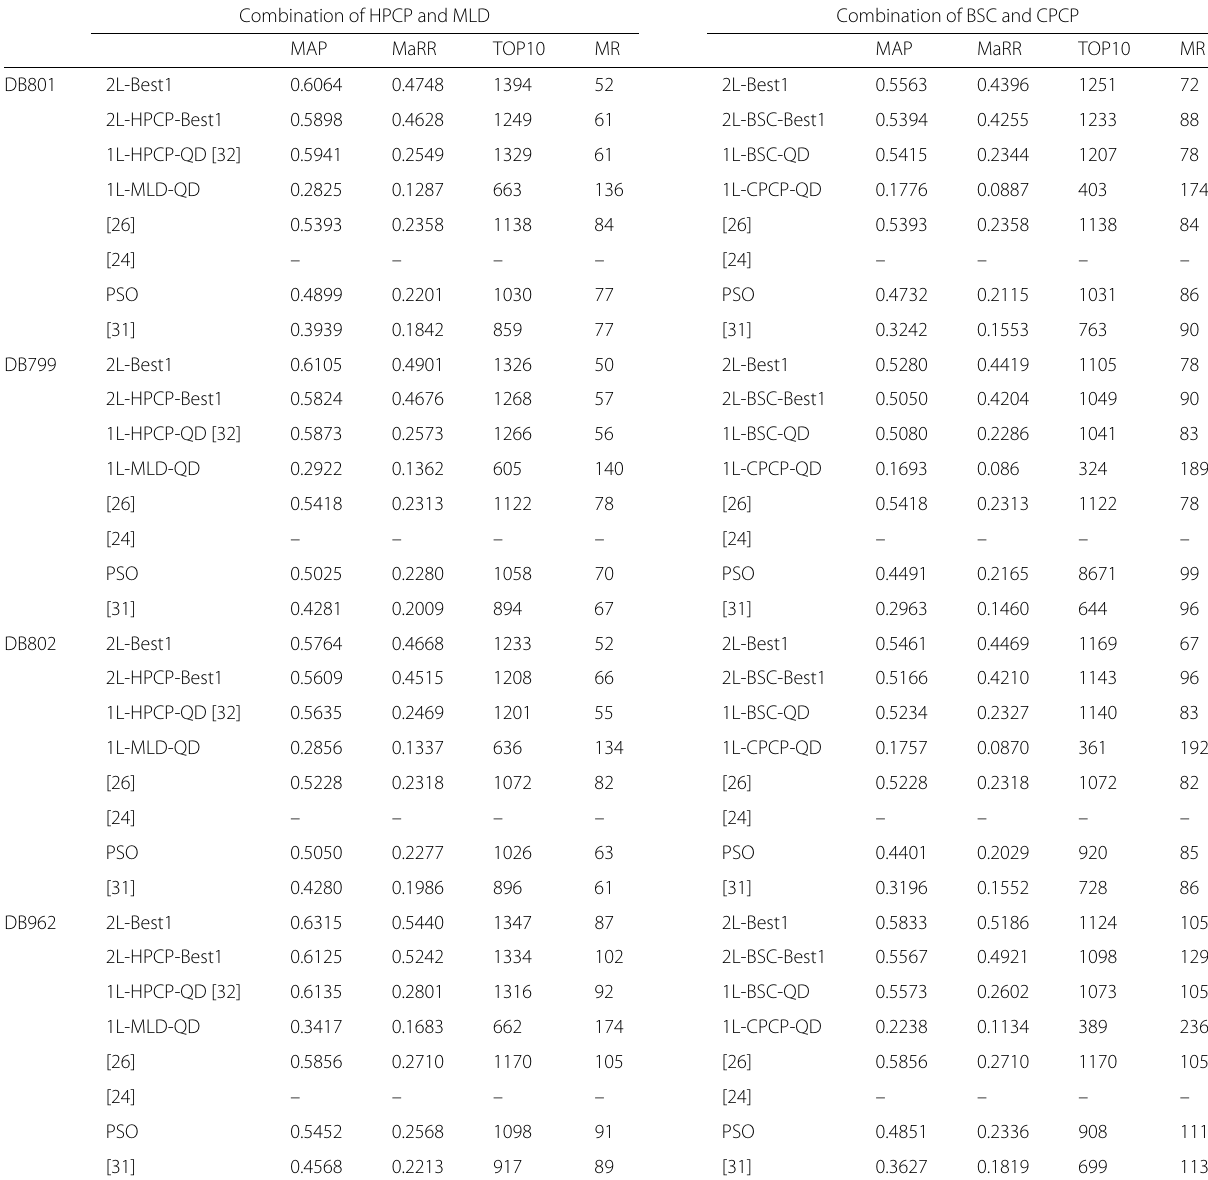
Table 5 Identification accuracy achieved by different descriptor combinations Combination of HPCP and